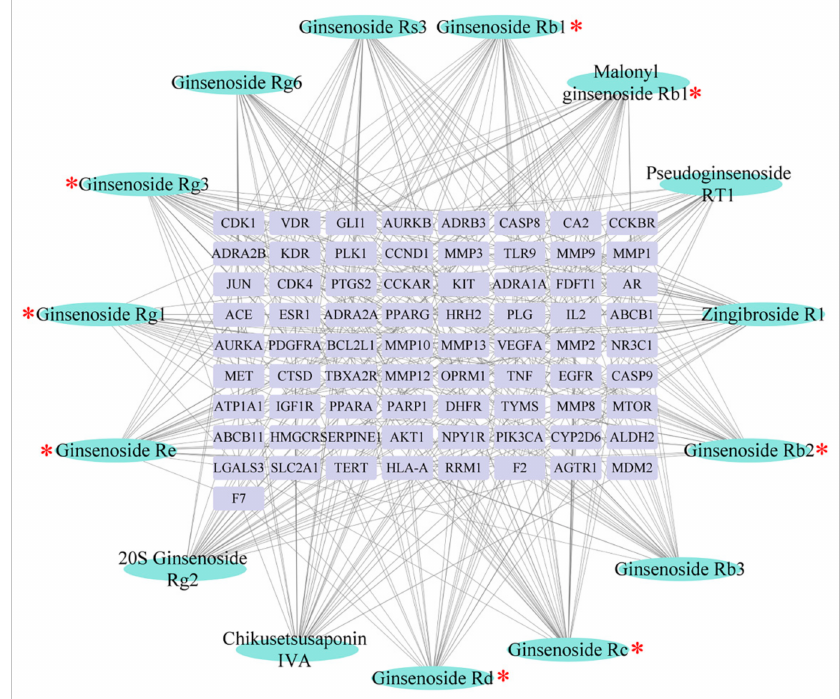
Figure 8. “Ingredient–target” network diagram (blue, ingredient; purple, target), * indicates ingredients with a higher than the average degree value (mean value = 27.4).